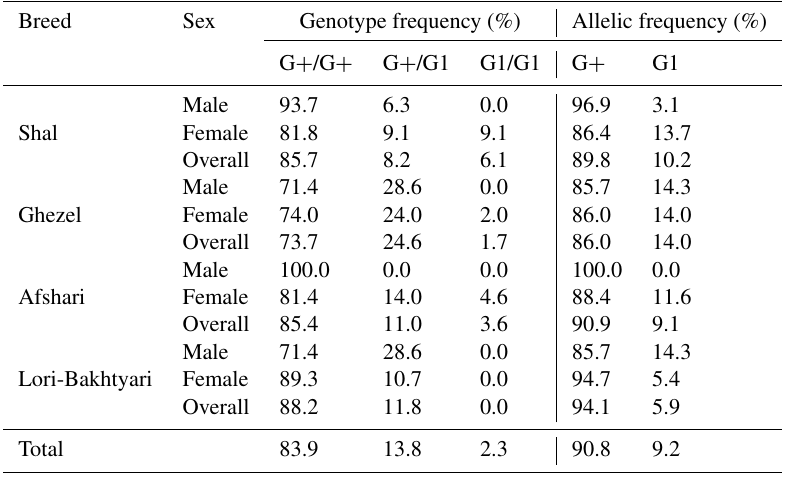
Table 4. Allelic and genotypic frequencies of the GDF9 G1 mutation (G260A) in Iranian Shal, Ghezel, Afshari, and Lori-Bakhtyari sheep breeds.